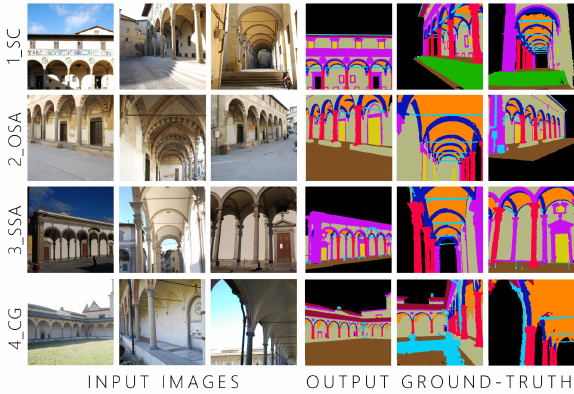
Figure 10 . Examples of labelled images in the dataset.